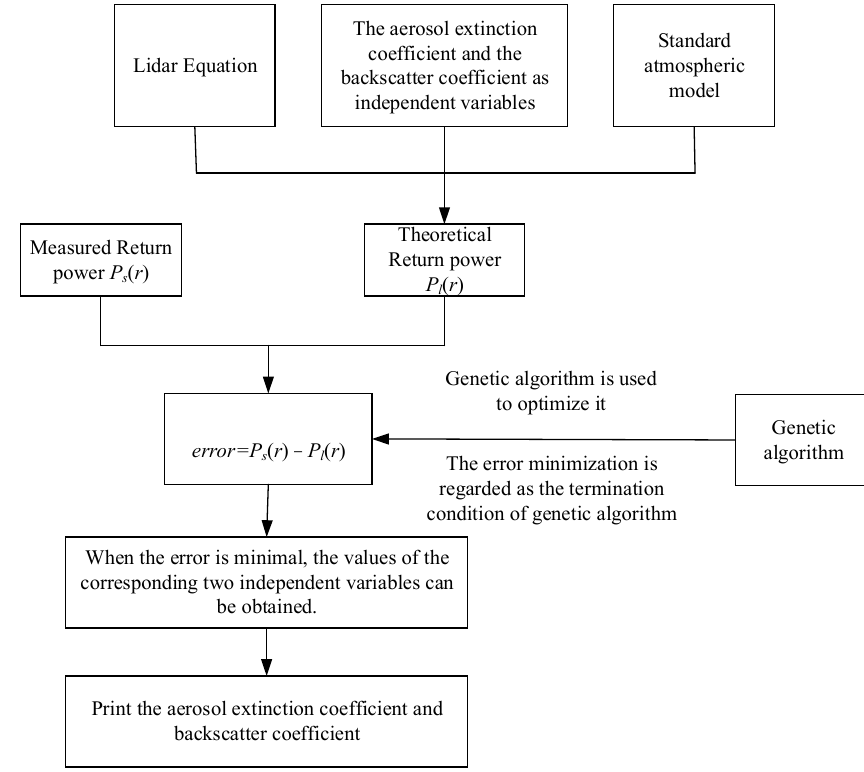
Figure 3. Block diagram of the inversion algorithm.